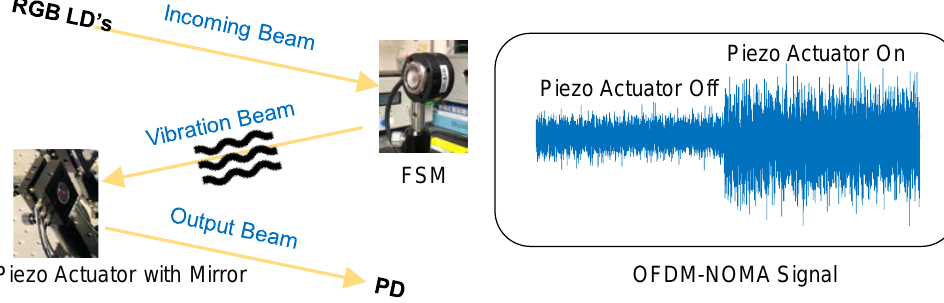
12 of 14 Table 1. Performance of vibration mitigation scheme. FSM Freq. (Hz) Rx Amp. (mV) Tracked by Piezo Time for Tracking and Feedback (s) 1